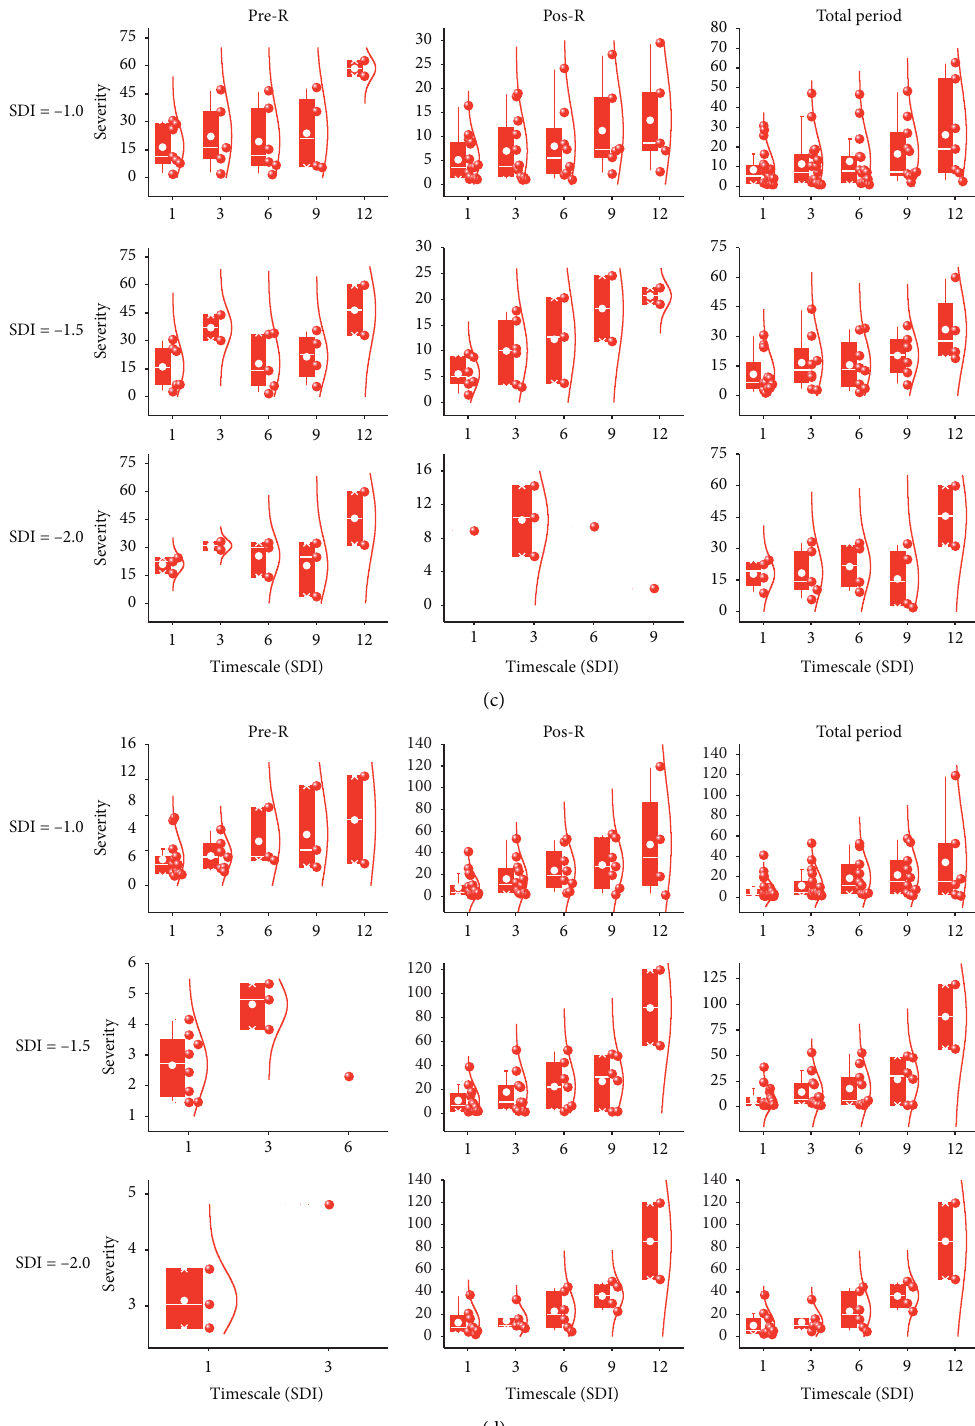
Figure 4: Boxplots showing HD duration and severity for Ylx (a, c) and for Zyx (b, d) based on SDI using thresholds of − 1, − 1.5, and − 2 for different timescales at different periods (the dot and midline in the boxplots are the mean and median; the upper and lower boundaries of box are the interquartile